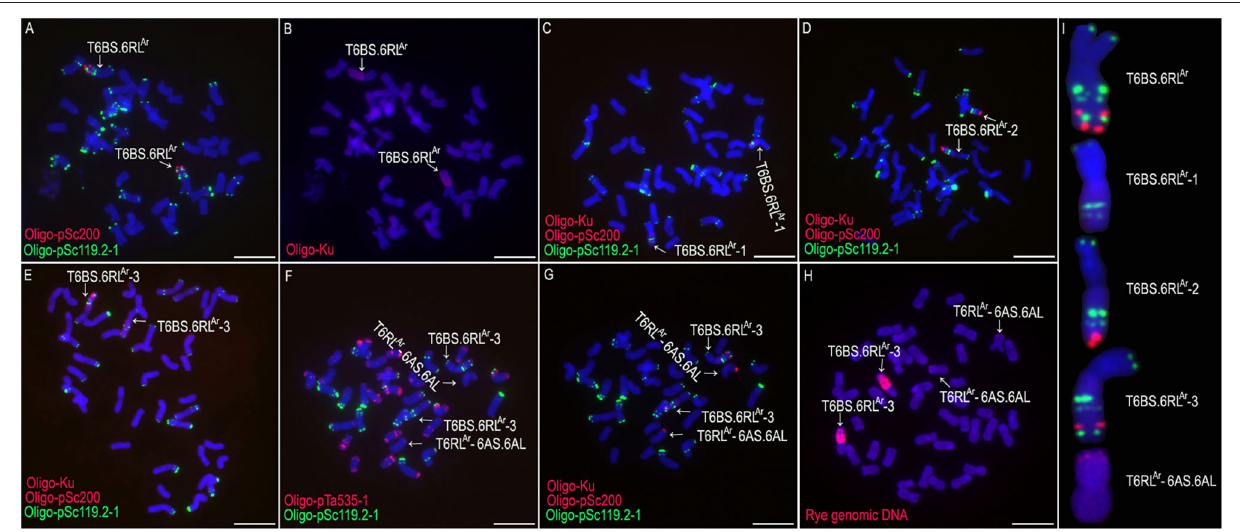
FIGURE 3 | The non-denaturing fluorescence in situ hybridization (ND-FISH) and genomic in situ hybridization (GISH) analyses of T6BS.6RL Ar translocations and its deleted T6BS.6RL Ar using probes Oligo-pSc119.2-1 (green), Oligo-pTa535-1 (red), Oligo-pSc200 (red), Oligo-Ku (red) and rye genomic DNA (red). (A,B) A root-tip metaphase cell of line 19T177-21. (C) A root-tip metaphase cell of line 21F1. (D) A root-tip metaphase cell of line 21F3. (E) A root-tip metaphase cell of line 21F7. (F,G) A root-tip metaphase cell of line 21F11. (H) GISH analysis of root-tip metaphase cell of line 21F11. (I) Cut-and-paste chromosomes of T6BS.6RL Ar and deleted T6BS.6RL Ar . Scale bar: 10 µ